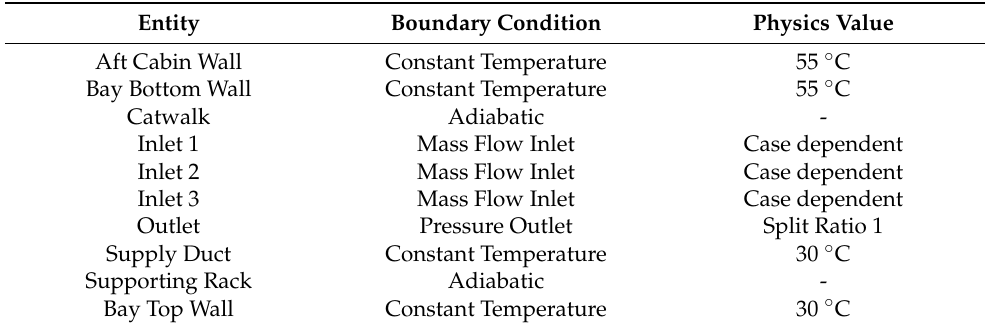
Boundary conditions for the CFD study of the cabin underfloor equipment bay (Configuration